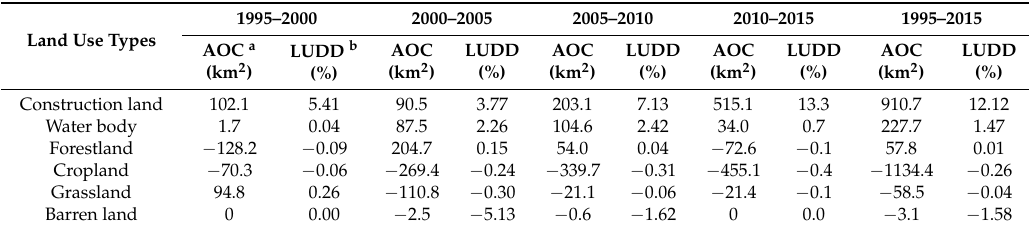
Table 2. Area of land use change and land use dynamic degree for the Three Gorges Reservoir Area during four dam construction periods, and for the entire 20-year period.